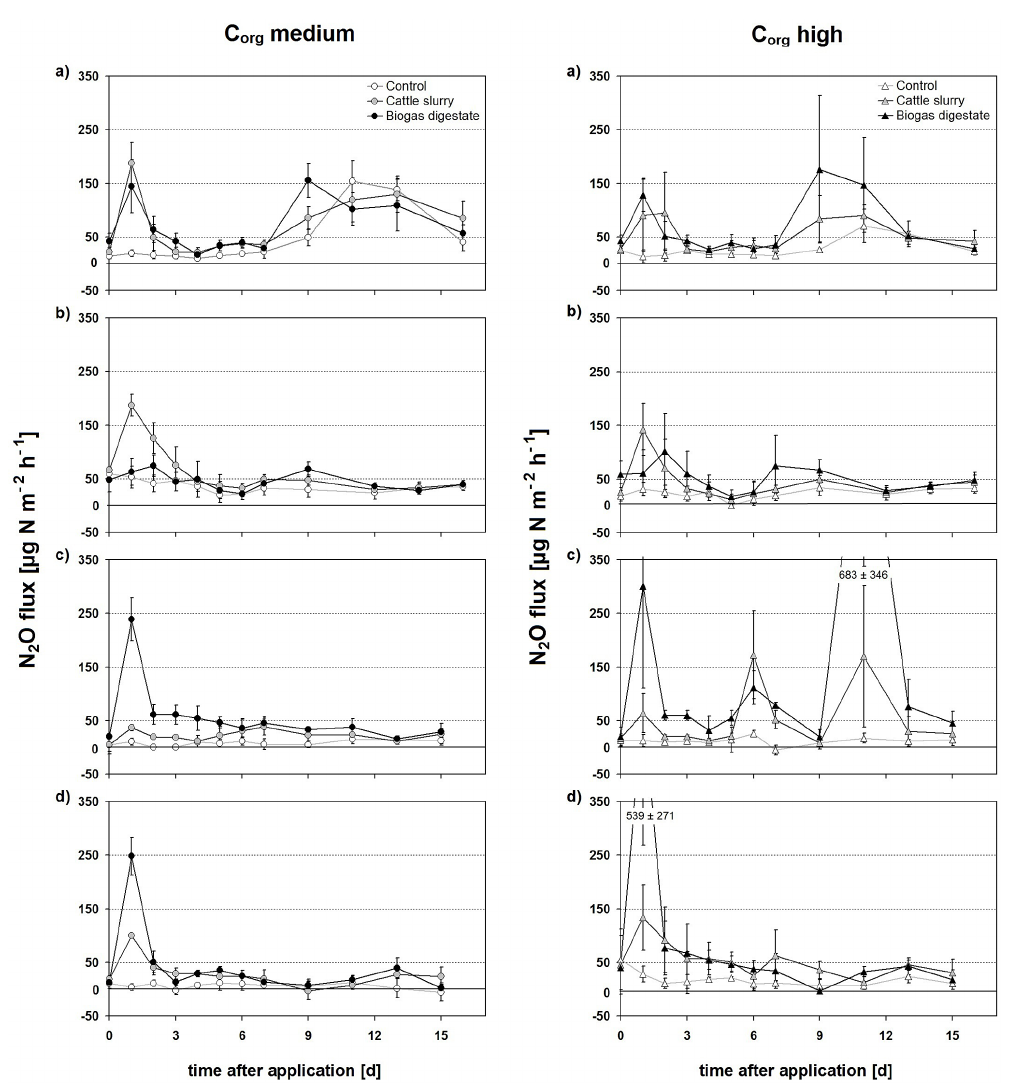
Figure 3. Mean ( ± SD, n = 3) N 2 O fluxes following organic fertilizer application events (a) 14–30 June 2010; (b) 25 August–10 Septem- ber 2010; (c) 27 May–11 June 2011 and (d) 22 September–7 October